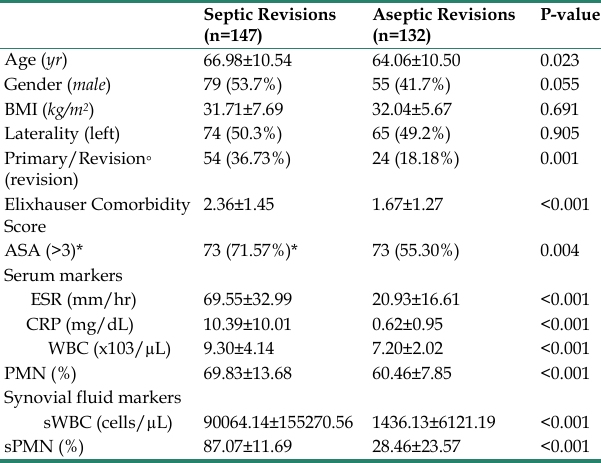
Table 1. Demographics and inflammatory markers of patient undergoing septic compared to aseptic total knee